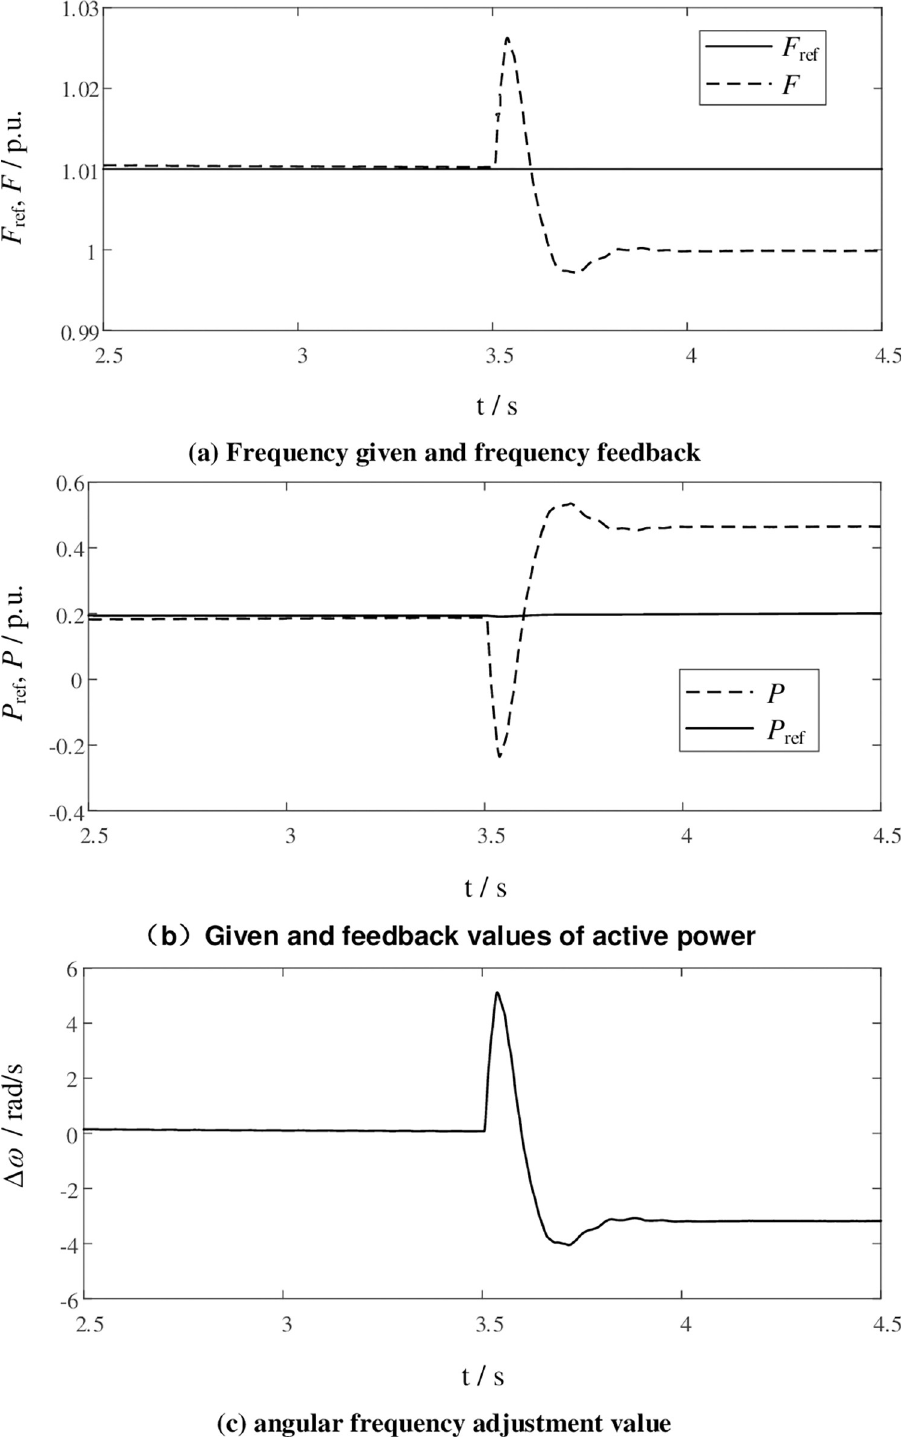
Fig 9. Switch form island to grid connection of